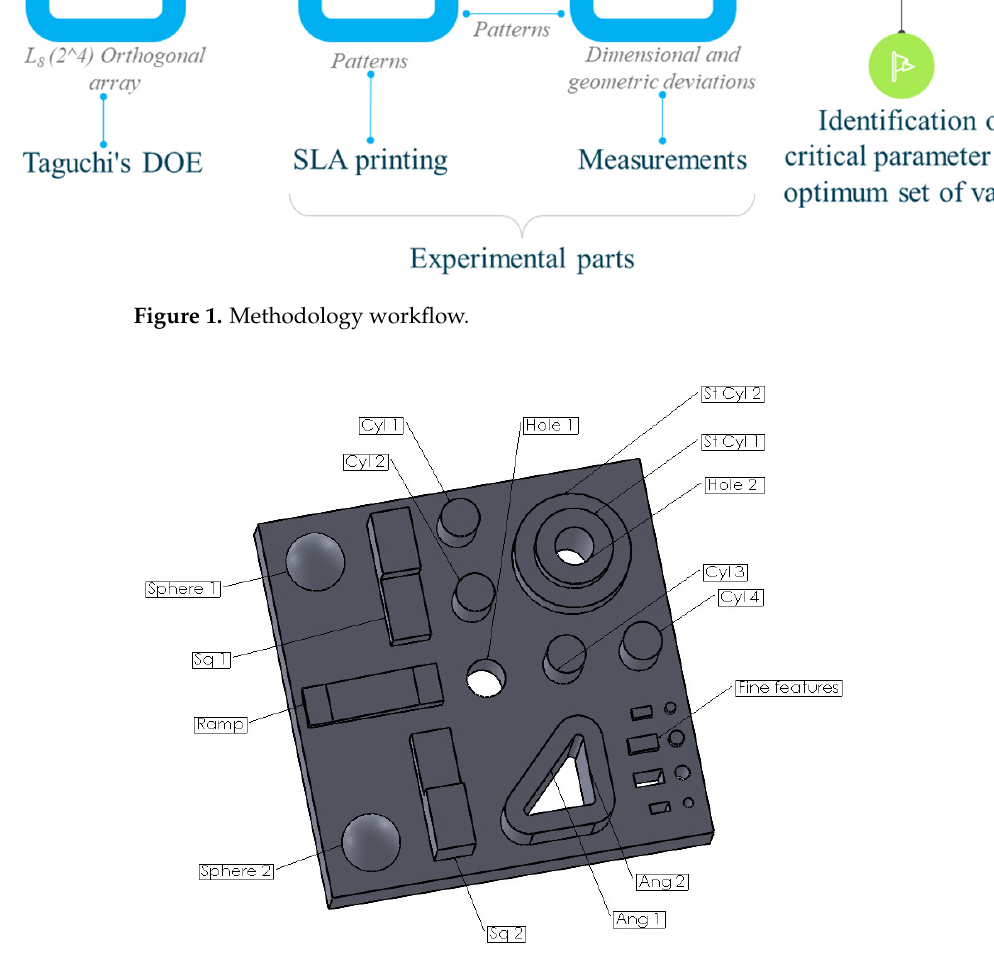
Figure 2. Benchmark model schematics.